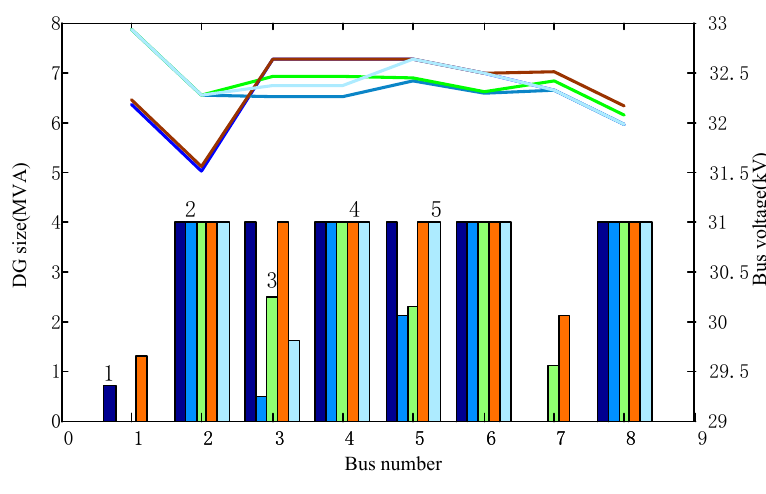
Figure 12. Voltage performance of five schemes.